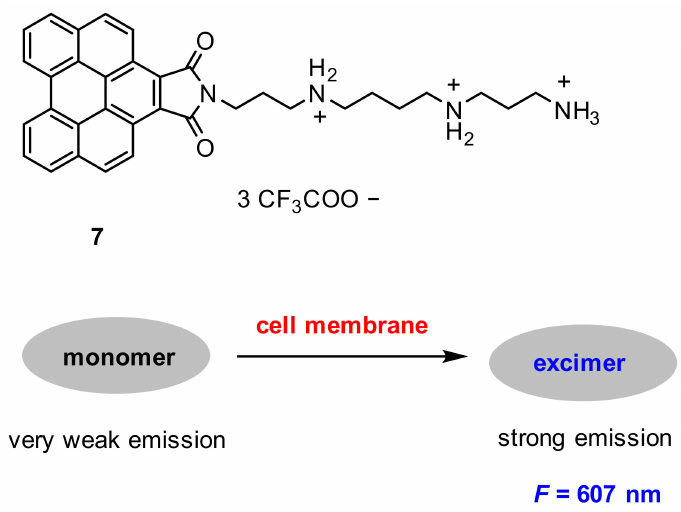
Figure 17. Chemical structure of probe 7 and its response to cell